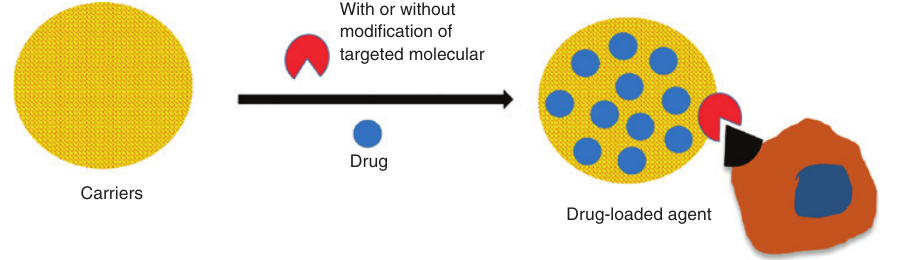
Figure 3: Schematic illustration of drug delivery systems (DDS) for anti-cancer drugs.